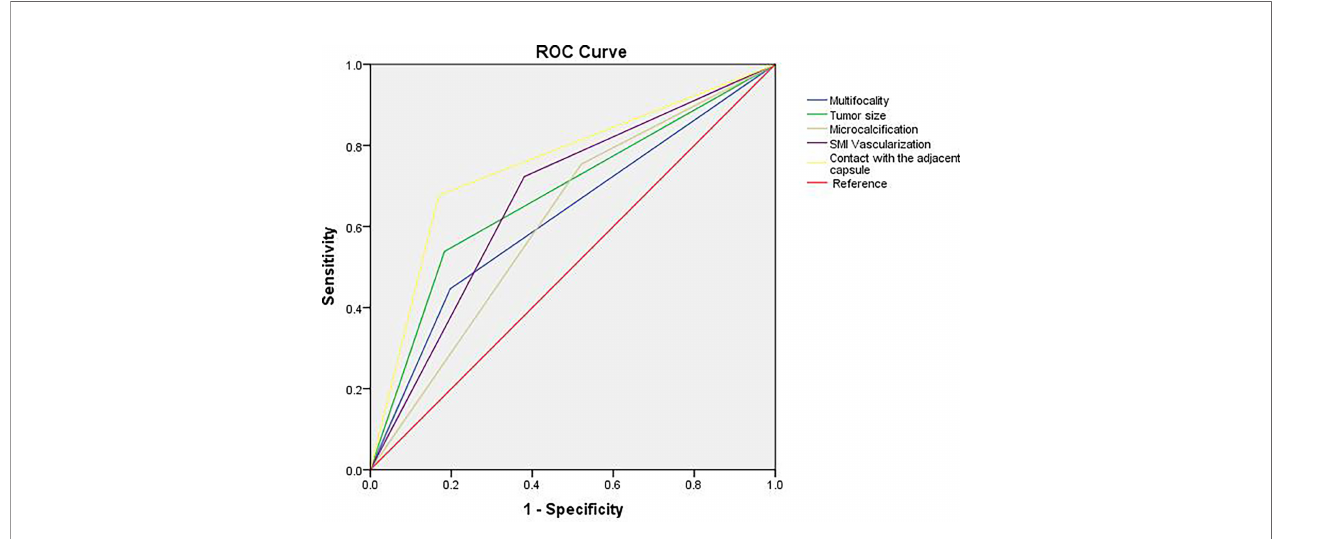
FIGURE 4 | ROC curve analysis for predicting central lymph node metastasis. AUC for contact with the adjacent capsule was the largest (AUC: 0.754), the sensitivity was 67.7% and the speci fi city was